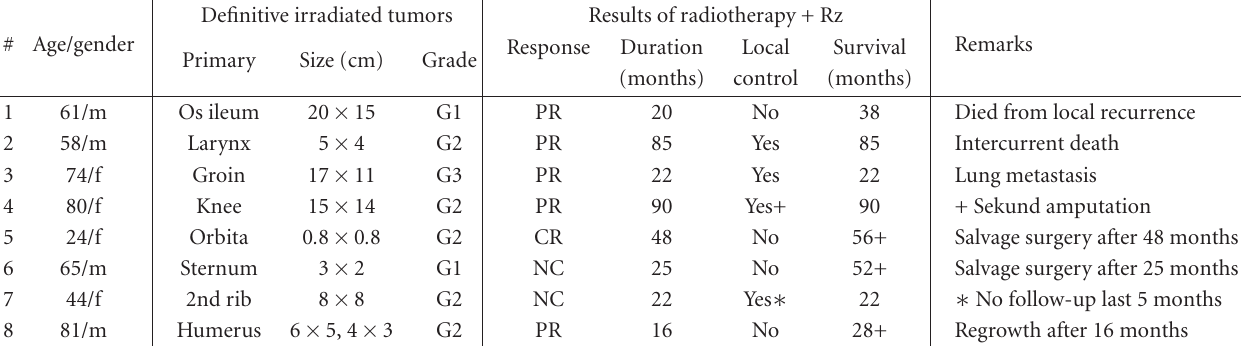
Table 1: Radiotherapy and razoxane in 8 patients with unresectable primary or recurrent